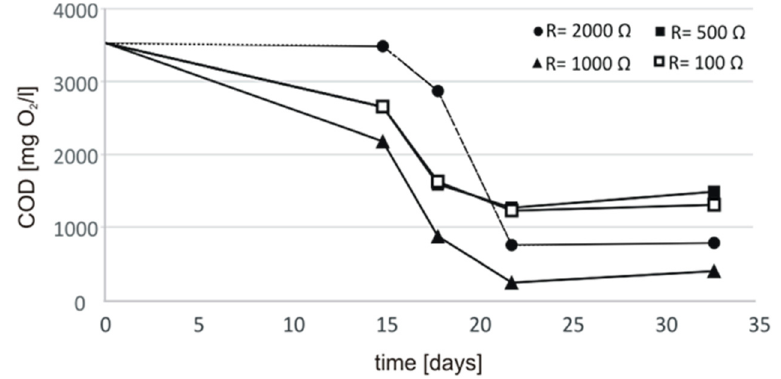
Figure 3. Changes of chemical oxygen demand (COD) in time in MFC fed mixed wastewaters under various external resistances. Analyses were made in duplicates, differences between measurements did not exceed 1%.